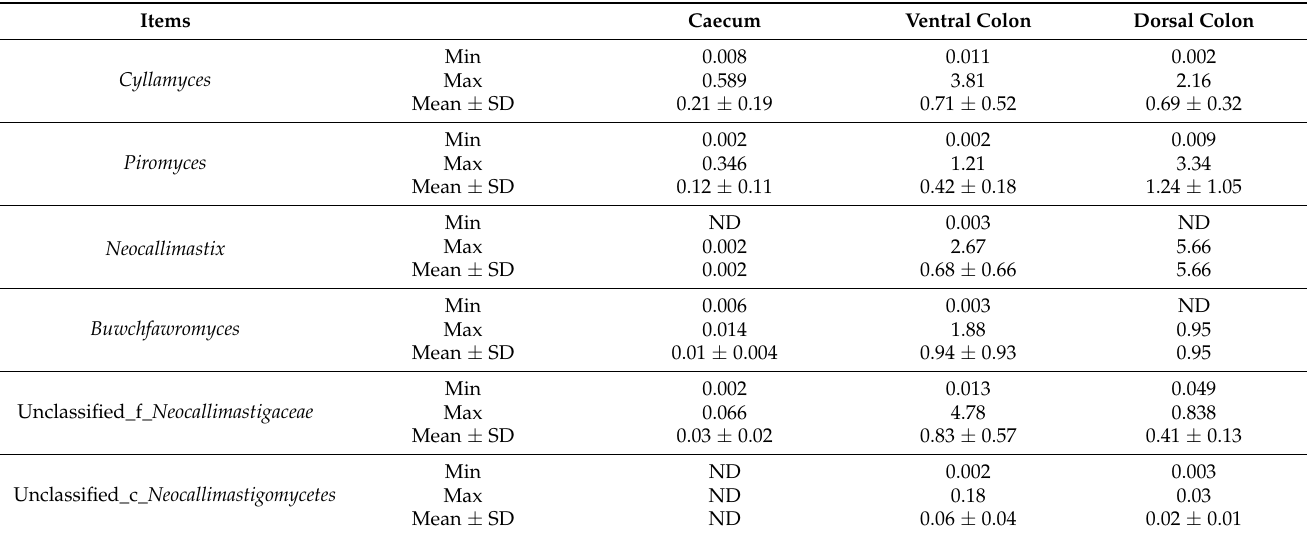
Table 3. The relative abundance of anaerobic fungal genera composition (belonging to the Neocalli- mastigomycota phylum) in donkey caecum and colon.